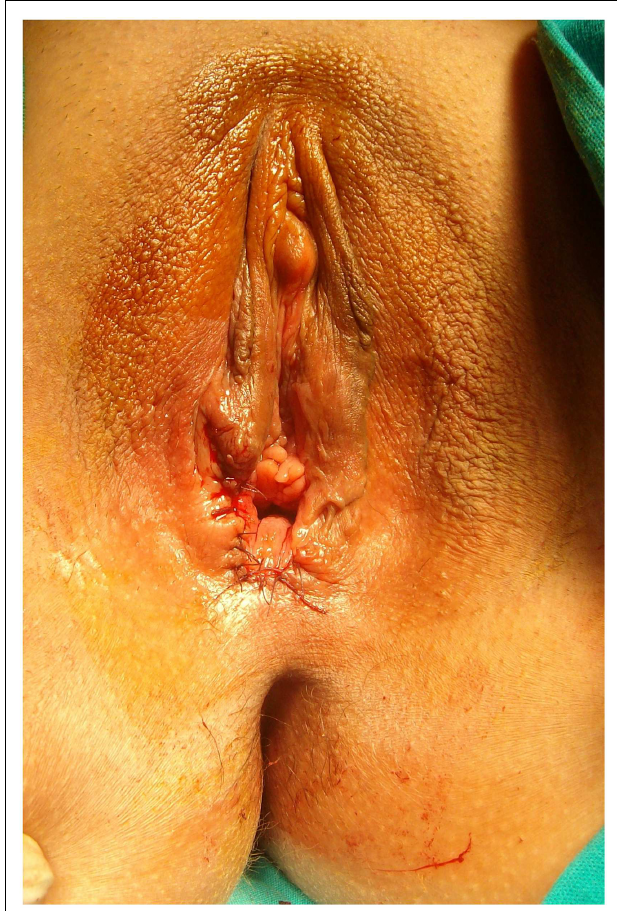
FIGURE 9 | Postoperative aspect of a vaginoplasty after an aggressive dissection of the posterior vaginal wall bringing the mucosa out to a wide perineal flap